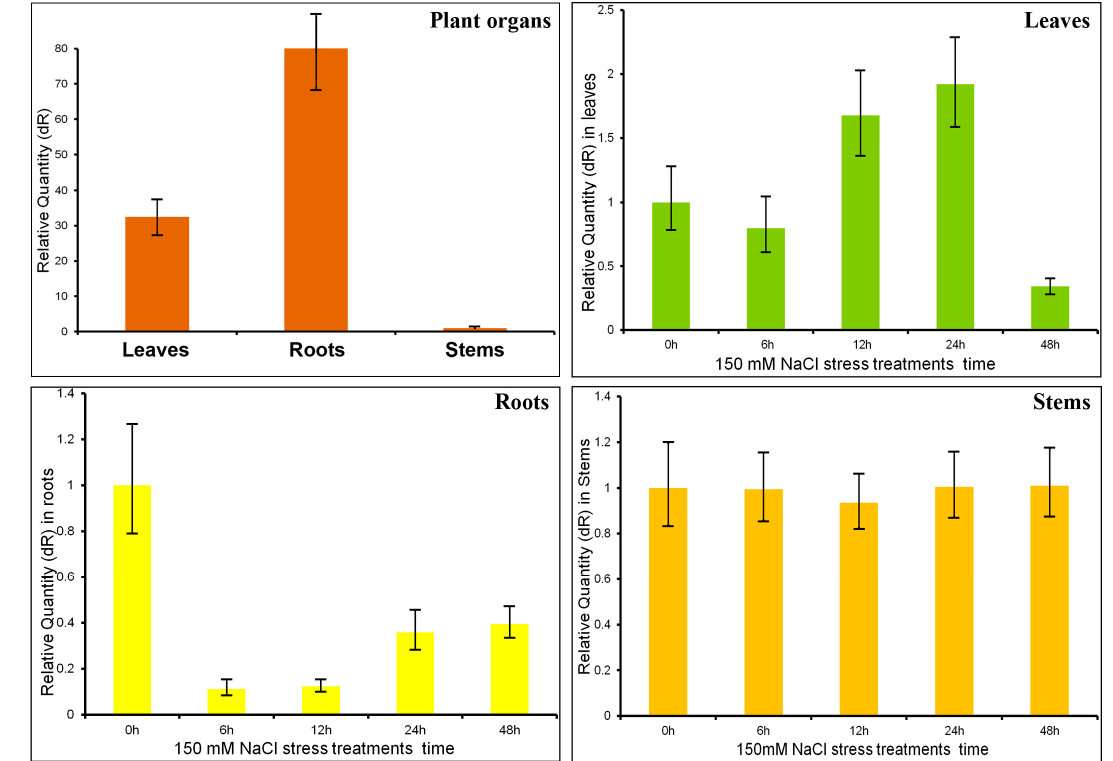
Figure 2. ( A ) PtMAPKK4 transcript levels in leaves, roots, and stems and under salt stress (NaCl) in ( B ) leaves; ( C ) roots; and ( D ) stems relative to the housekeeping gene Actin2 (error bars indicate SE of three replicates).